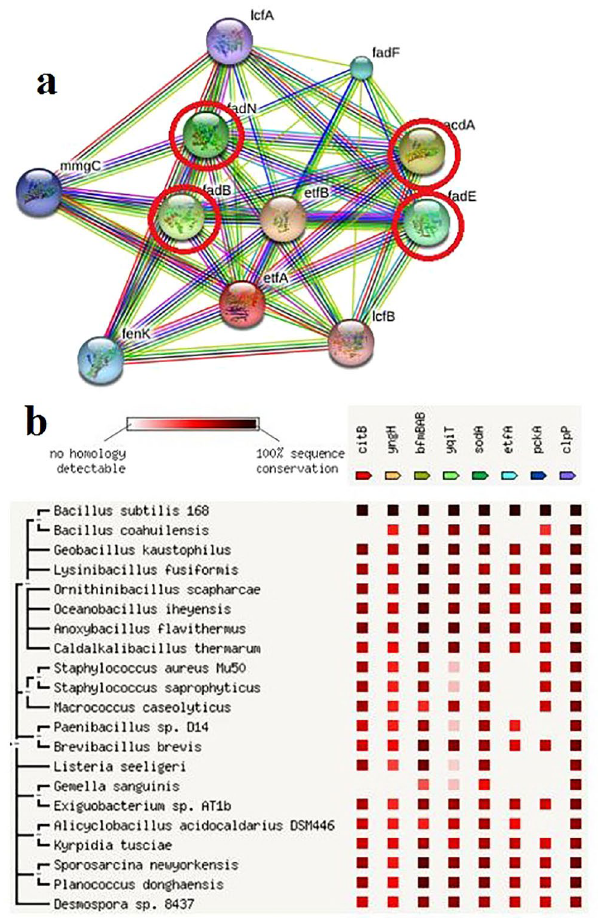
Figure 4. Analysis of effector proteins with same expression trends in different experiments. ( a ) protein network of electron transfer flavoprotein subunit alpha (medium confidence: 0.400); ( b ) homology analysis of different